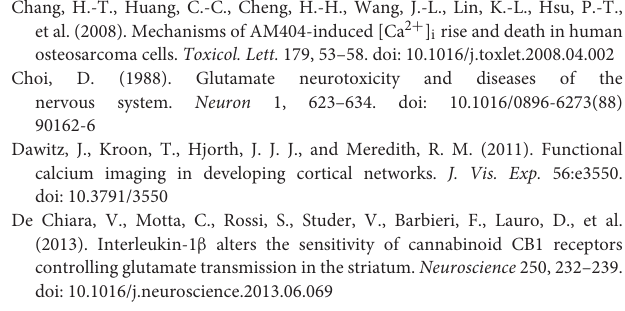
FIGURE S1 | Effects of NMDA on levels of inflammatory mediators in OHSC. The OHSCs were stimulated with LPS or NMDA (10–50 µ M). After 4 h, IL-1 β (A) , IL-6 (B) , TNF α (C) , mPGES-1 (D) , and iNOS (E) were measured by qPCR. After 24 h, COX-2 (F) was evaluated by western blot. Data are expressed as mean ± SEM of at least three OHSCs/group. ∗ p < 0.05, ∗∗ p < 0.01 and ∗∗∗ p < 0.001 with